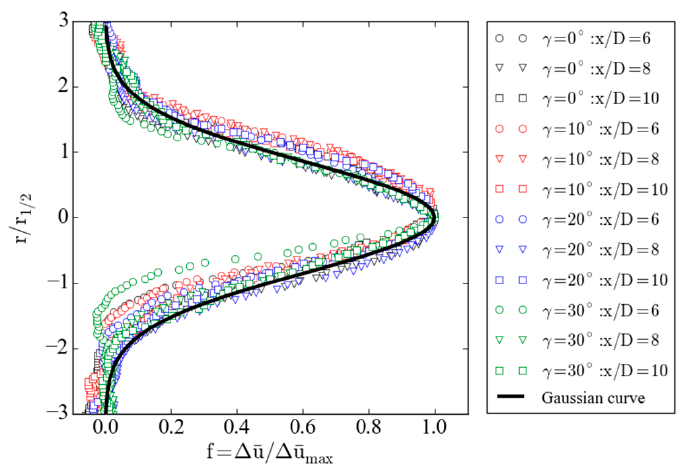
Figure 6. The self-similar lateral profiles of the streamwise velocity deficit at different downstream locations for different yaw angles.